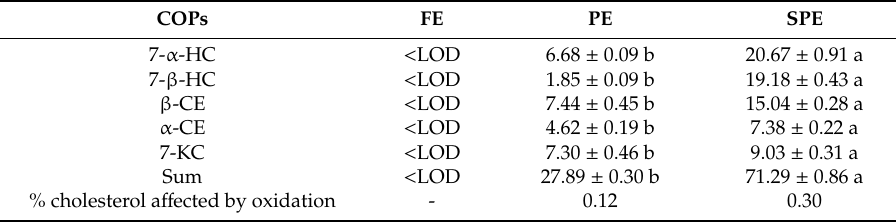
Table 3. COPs content ( µ g / g fat) in FE, and PE and SPE egg products.